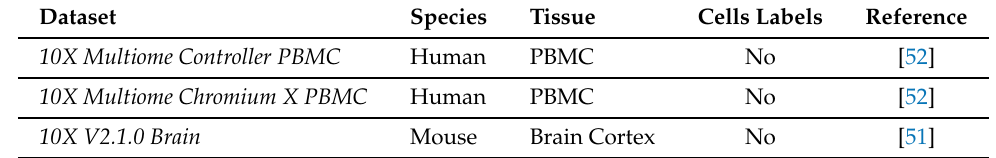
Table 2. New datasets employed.